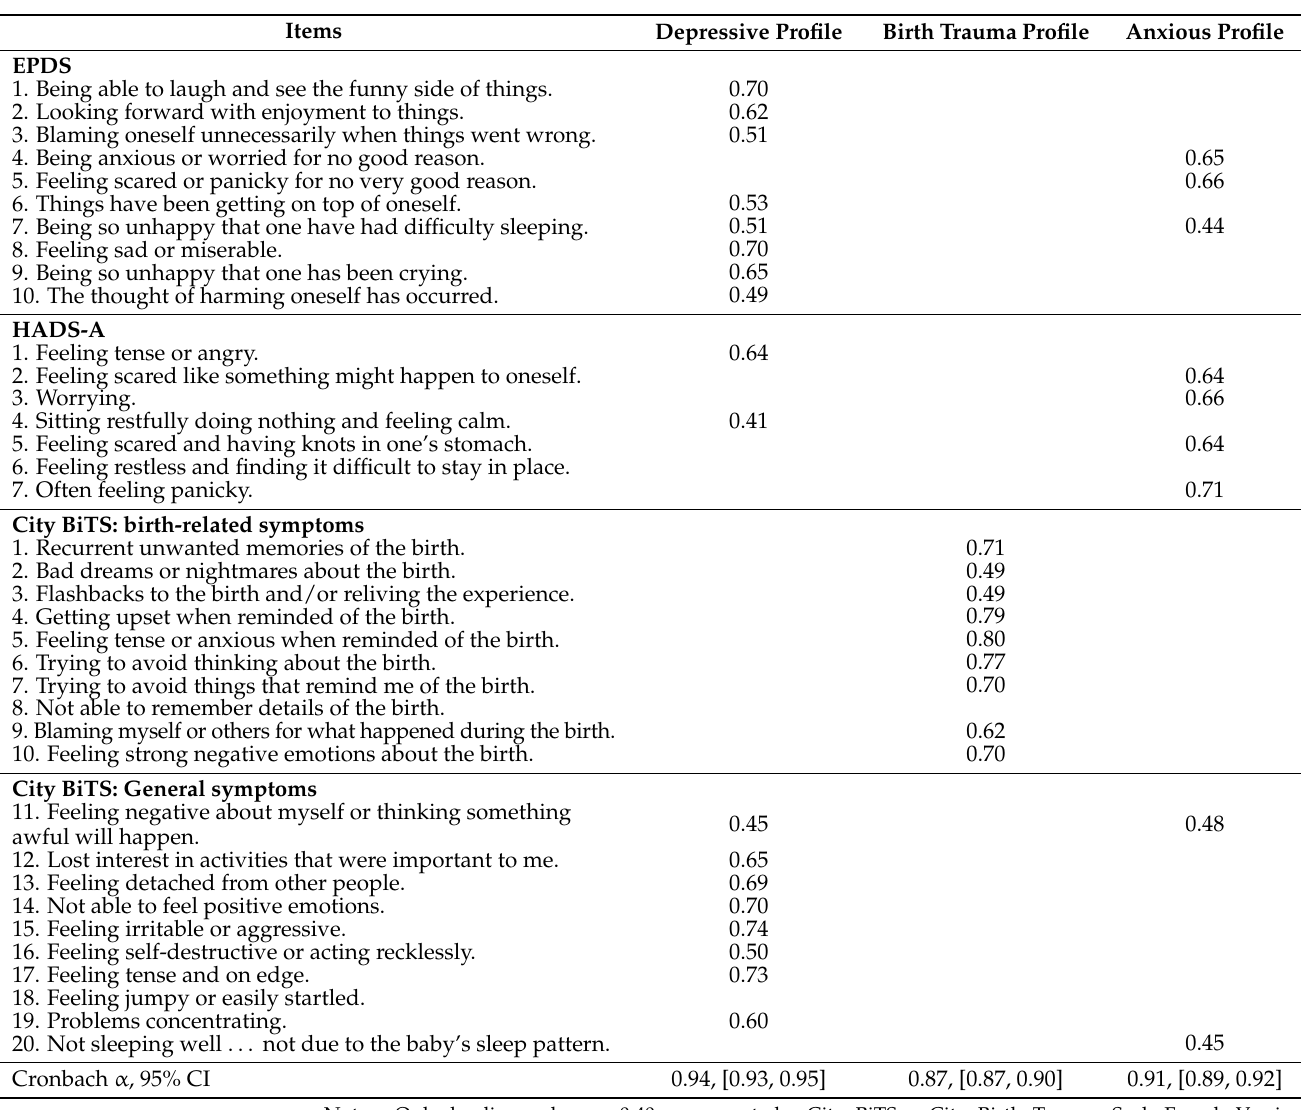
Table 3. Exploratory factor analysis with three predefined factors ( n =